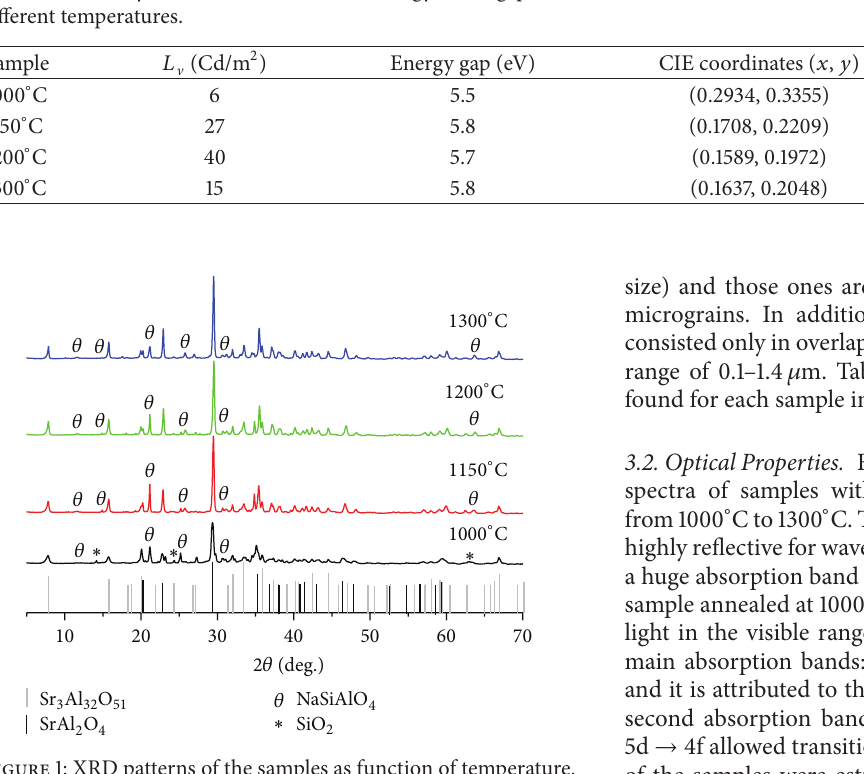
three crystalline phases: firstly, the SrAl 2 O 4 hexagonal phase (JCPDS 311336), second the Sr 3 Al 32 O 51 hexagonal phase (JCPDS 440024), and lastly the NaSiAlO 4 orthorhombic phase (JCPDS 390376). The sample annealed at 1000 ∘ C had a fourth phase SiO 2 , and it is labeled with the symbol ∗ . The SrAl 2 O 4 and Sr 3 Al 32 O 51 standard patterns are plotted at the bottom of Figure 1 in black and gray vertical lines and the NaSiAlO 4 phase is marked with the 𝜃 symbol on the XRD patterns in all the samples. Furthermore, the intensity of the diffraction peaks of the NaSiAlO 4 phase is higher for the samples annealed at 1150 ∘ C and 1200 ∘ C in comparison with the samples annealed at 1000 ∘ C and 1300 ∘ C. This suggests that the amount of the NaSiAlO 4 is lower in the samples annealed at 1150 ∘ C and 1200 ∘